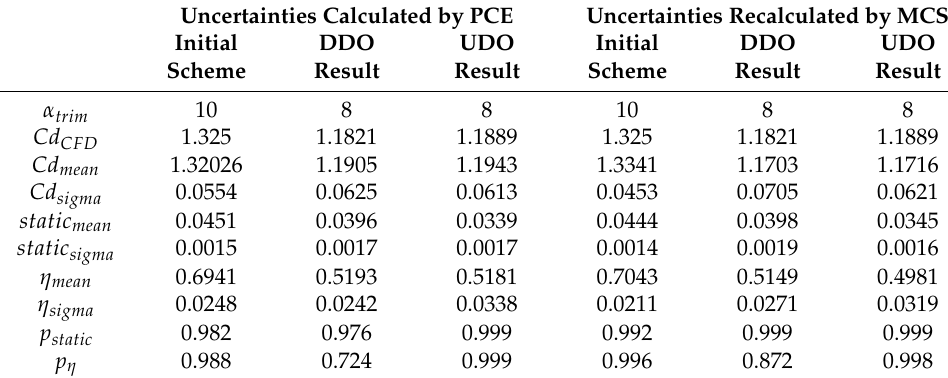
Table 7. PCE and MCS of different optimization.